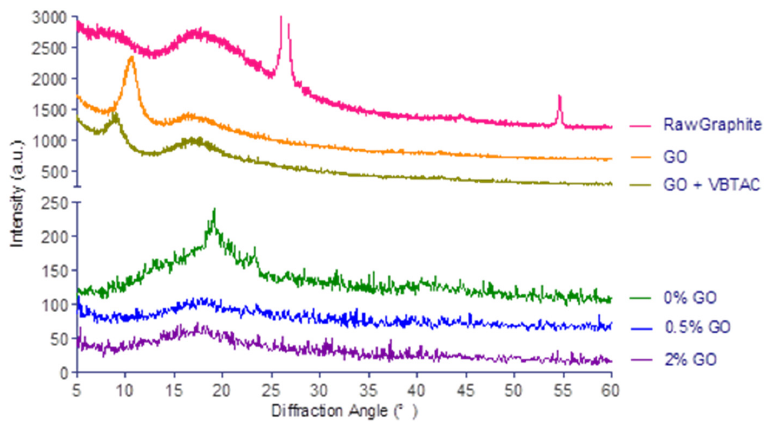
Figure 5. XRD spectra of raw graphite, GO, VBTAC-modified GO, GO / PMMA composites after miniemulsion with 0%, 0.5%, and 2% GO.